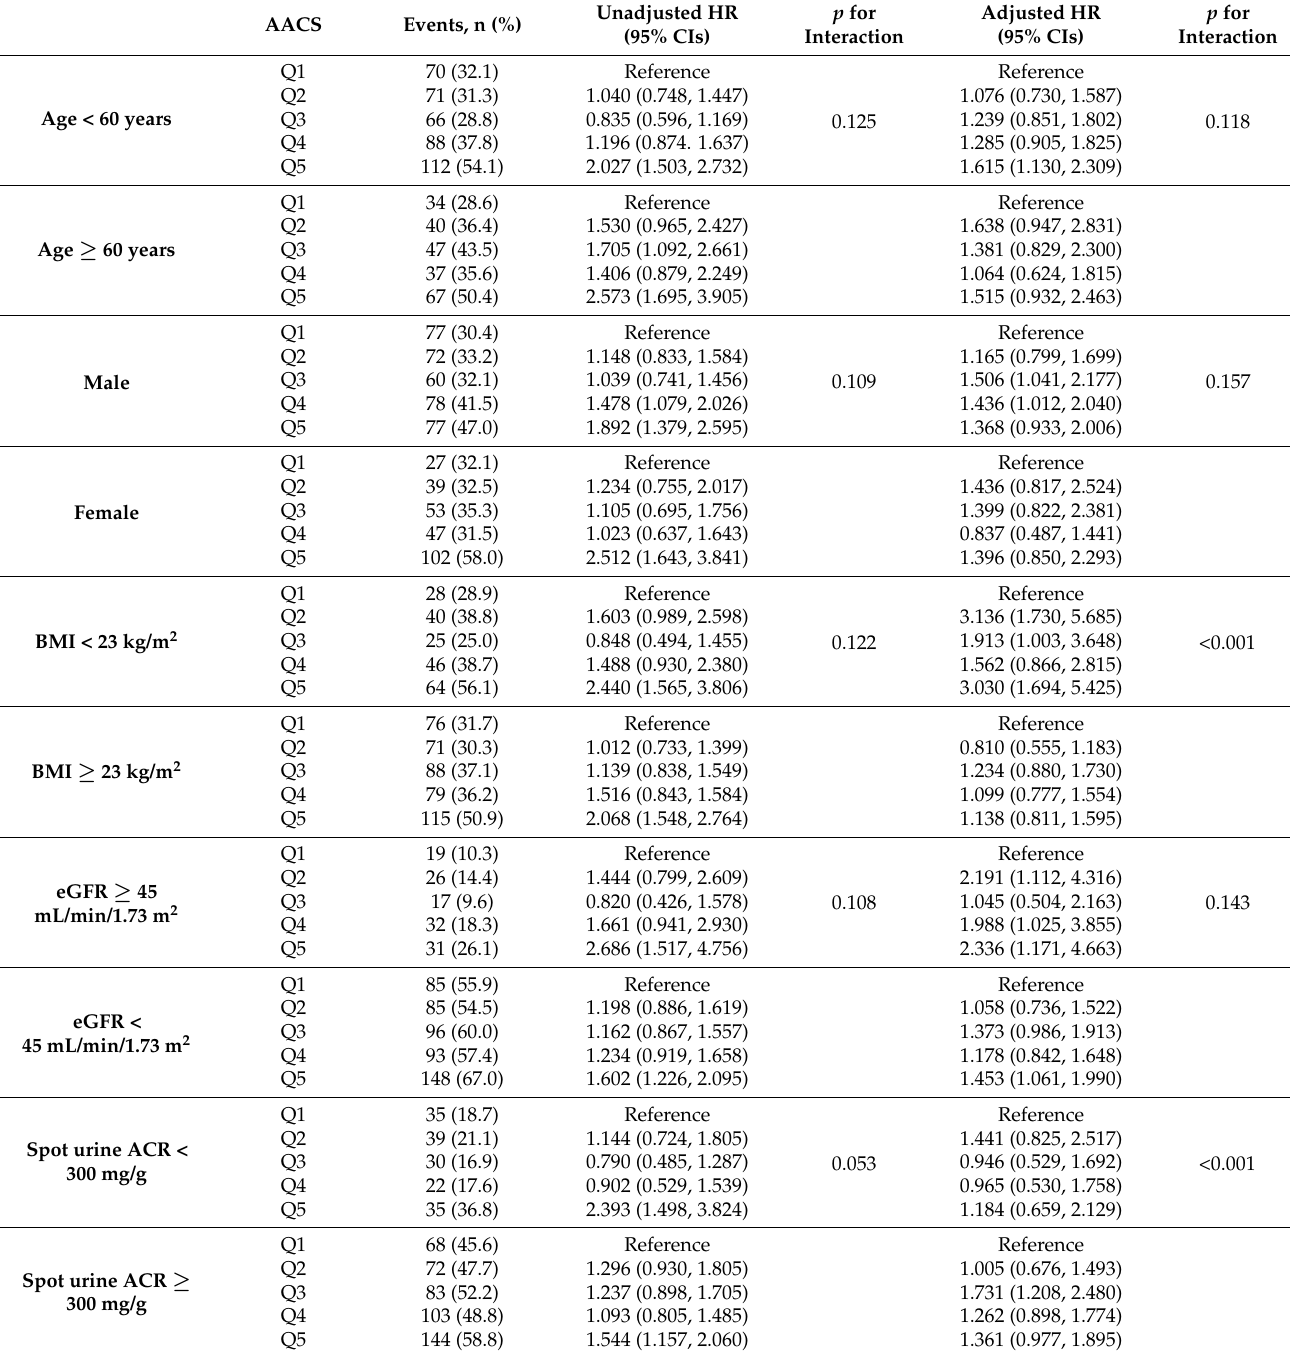
Table 5. HRs for composite renal events by UAGT/Cr in various